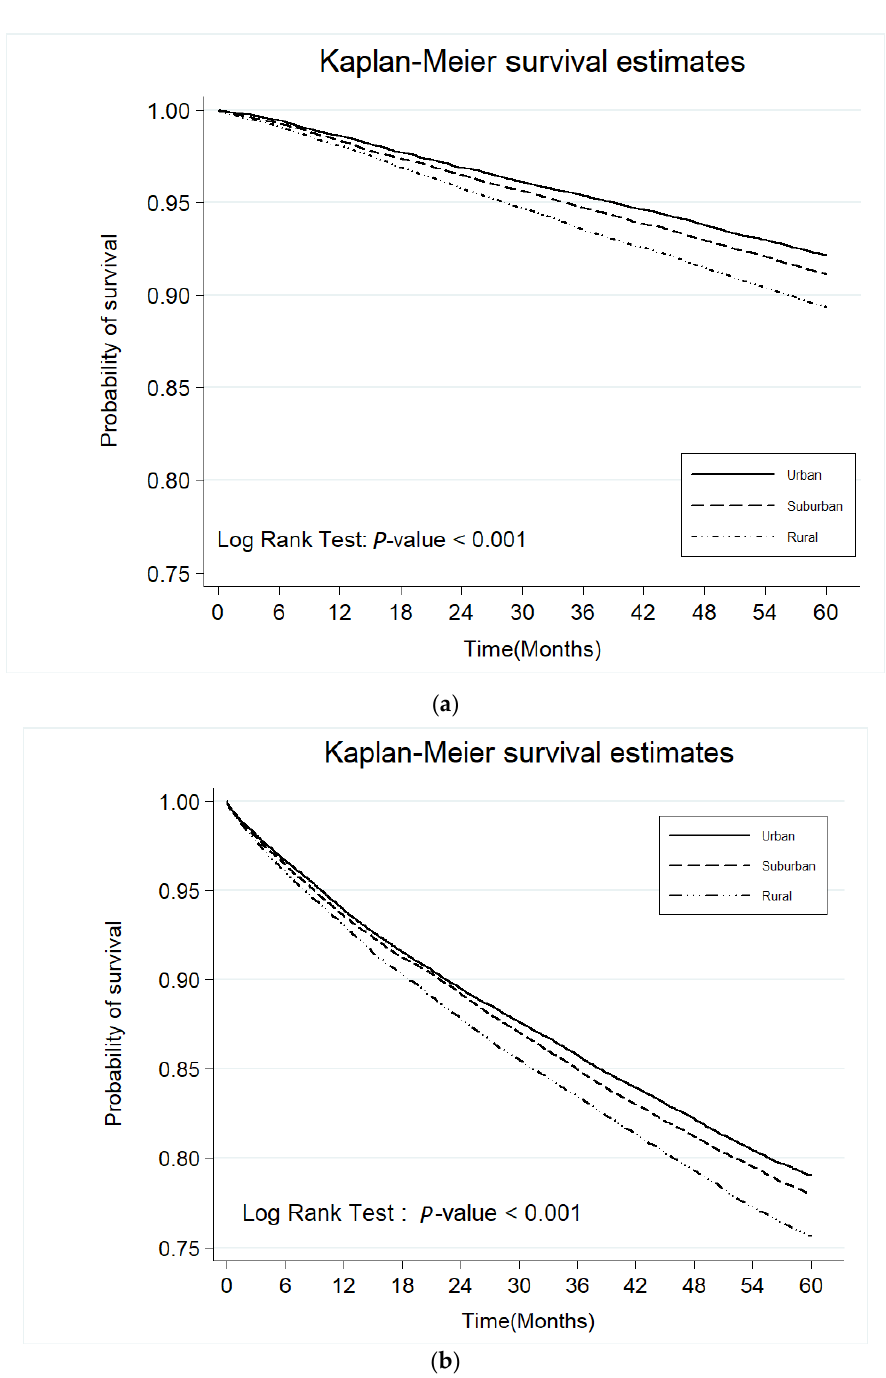
Figure 2. Kaplan–Meier survival curves. ( a ) All ‐ cause mortality; ( b ) All CV events by urbanization.